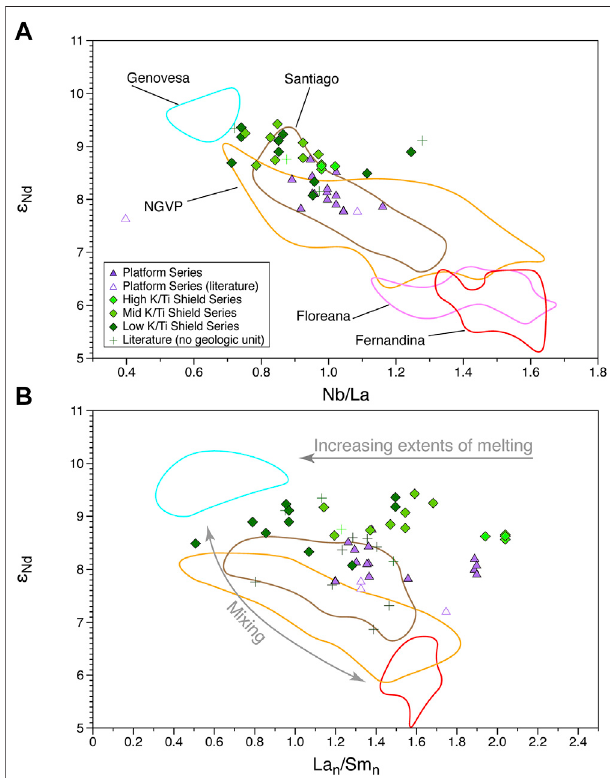
FIGURE 9 | Variations in radiogenic isotope ratios and incompatible trace element ratios for Santa Cruz lavas. Fields are literature data. Red: Fernandina, blue: Genovesa, brown: Santiago, pink: Floreana, yellow: Northern Galápagos Volcanic Province (Bow and Geist, 1992; White et al., 1993; Harpp et al., 2002; Harpp et al., 2003; Saal et al., 2007; Gibson andGeist,2010;Gibsonetal.,2012;Harppetal.,2014a;Harppetal.,2014c). Symbolsarelargerthan1 σ analyticalerror. (A) Nb/Laversus ε Nd . (B) La n / Sm n (normalizedtoprimitivemantle;McDonoughandSun,1995)versus ε Nd . Samples indicated by a cross are literature data from Santa Cruz (Whiteetal.,1993;KurzandGeist,1999;Saaletal.,2007);theyhavenot been attributed to either the Platform or Shield Series owing to a lack of GPS coordinates for their origin